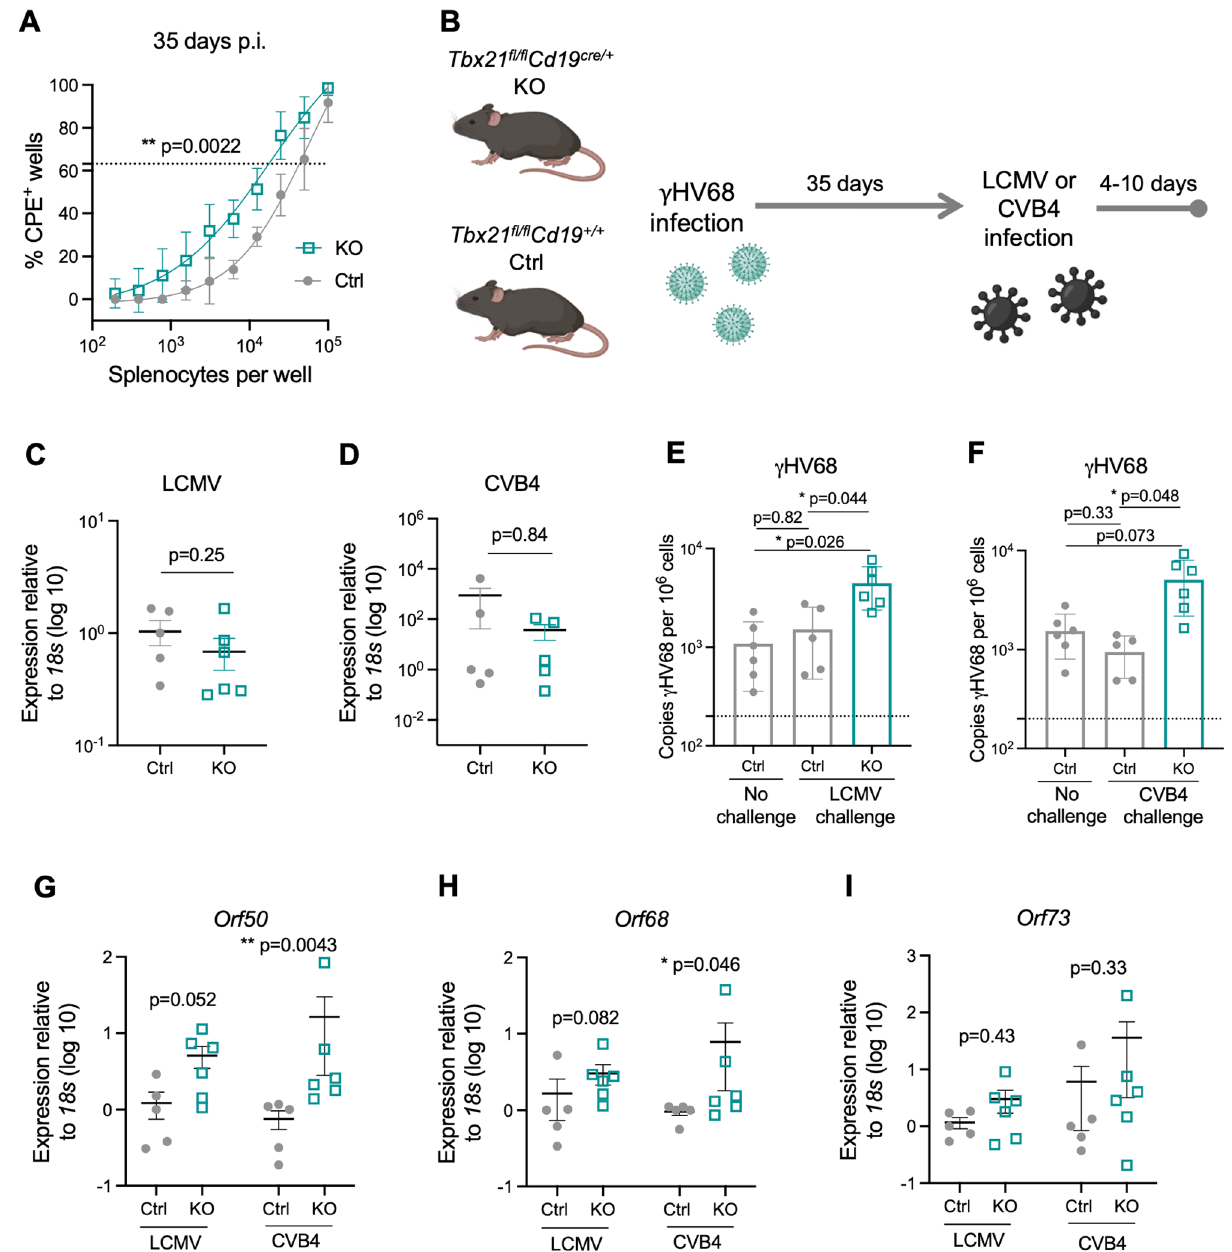
Figure 6. ABC knockout mice are more susceptible to reactivation. ( A ) Tbx21 fl/fl Cd19 + / + (Ctrl, filled grey circles) and Tbx21 fl/fl Cd19 cre/ + (KO, open blue squares) mice were infected i.p. with γHV68. 35 days p.i., spleens were collected and processed for reactivation assay. N = 6 mice per group, data compiled from two independent experiments. ( B ) Experimental scheme for data shown in panels ( C–I ). Ctrl and KO mice were infected i.p. with γHV68 for 35 days and then challenged with either LCMV (Armstrong) or CVB4 for 10 to 4 days, respectively. ( C–I ) Spleens collected, processed, and DNA and RNA was extracted from total splenocytes following RBC lysis. ( C,D ) Relative expression of LCMV ( C ) and CVB4 ( D ) between Ctrl and KO mice measured by RT-qPCR. ( E,F ) Copies of γHV68 detected by qPCR in the spleen per million cells following challenge with LCMV or CVB4. ( G–I ) Relative expression in the spleen of Orf73 , Orf50 , and Orf68 in Ctrl and KO mice. Each data point represents an individual mouse. Both male and female mice included in experiments. Data presented as mean ± SEM, analyzed by Mann–Whitney test ( A,C,D,G–I ) or one-way ANOVA ( E,F ). p-values indicated as asterixis as follows: **p < 0.01, *p <